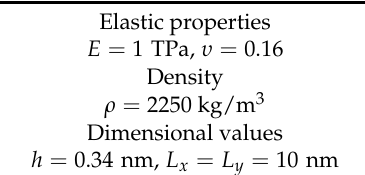
Table 4. Material properties of the viscoelastic nanoplate [36]. Elastic